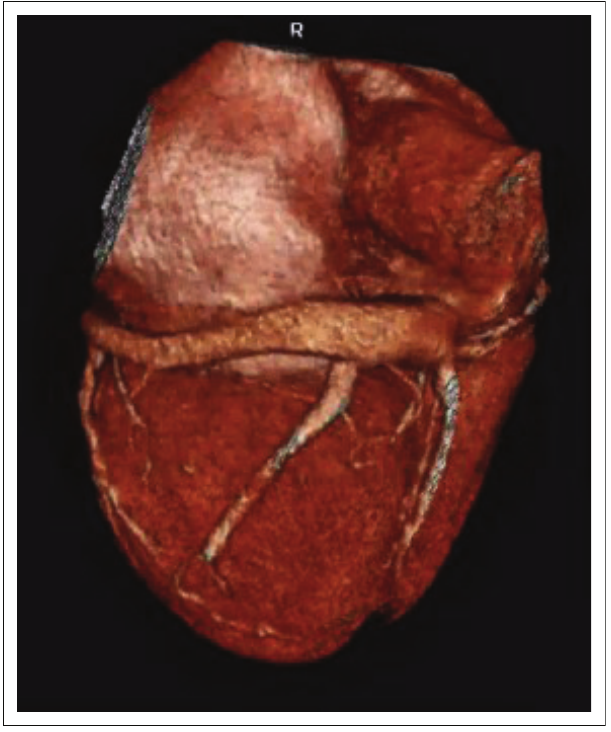
FIGURE 9: Surface-rendered CTA demonstrates the path of the coronary sinus and coronary veins, for planning of implantation of a biventricular pacemaker or